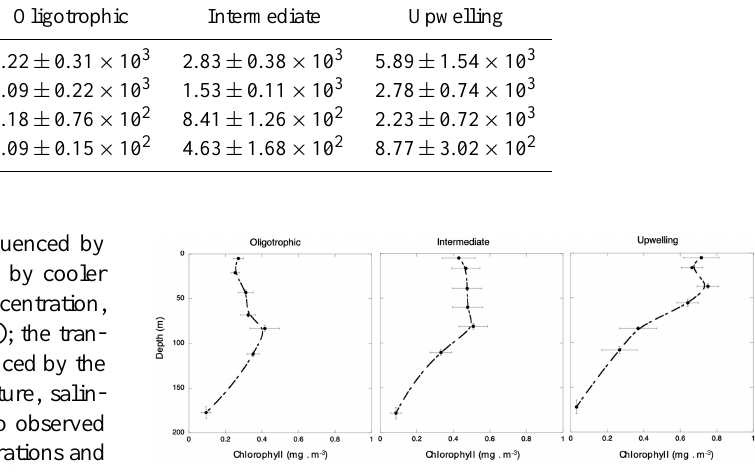
Figure 2. Profile plots showing the relationships between chloro- phyll a concentrations and depth by zones of